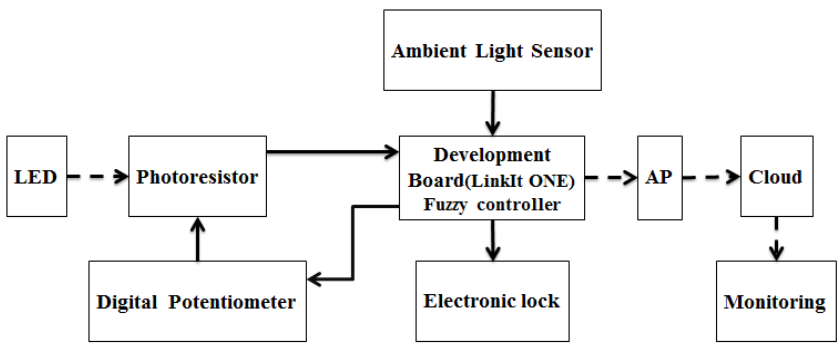
Figure 3. System Architecture diagram of the novel electronic lock.